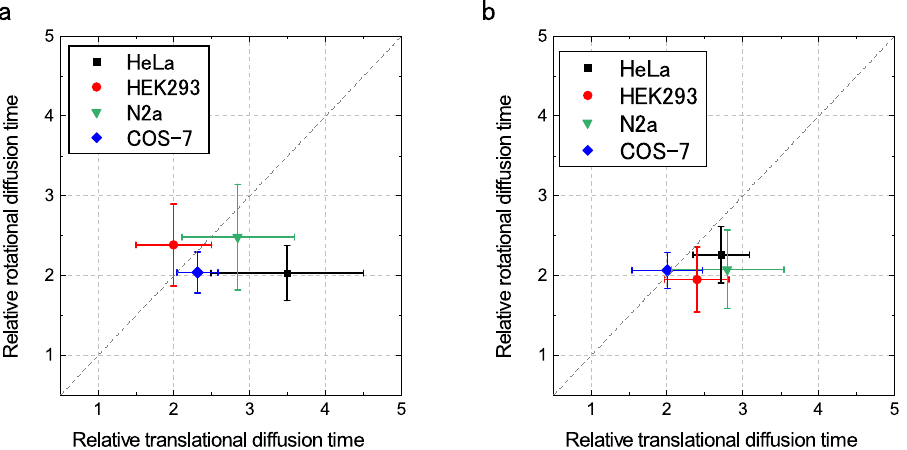
Figure 5. Pol-FCS result of GFP in different cell lines. The translational/rotational diffusion times were normalized by these values of GFP solution in PBS. ( a ) Results without nocodazole treatment. ( b ) Results with nocodazole treatment. The excitation laser power was 11 µW (5.6 kW/cm 2 ). The measurement duration was 100